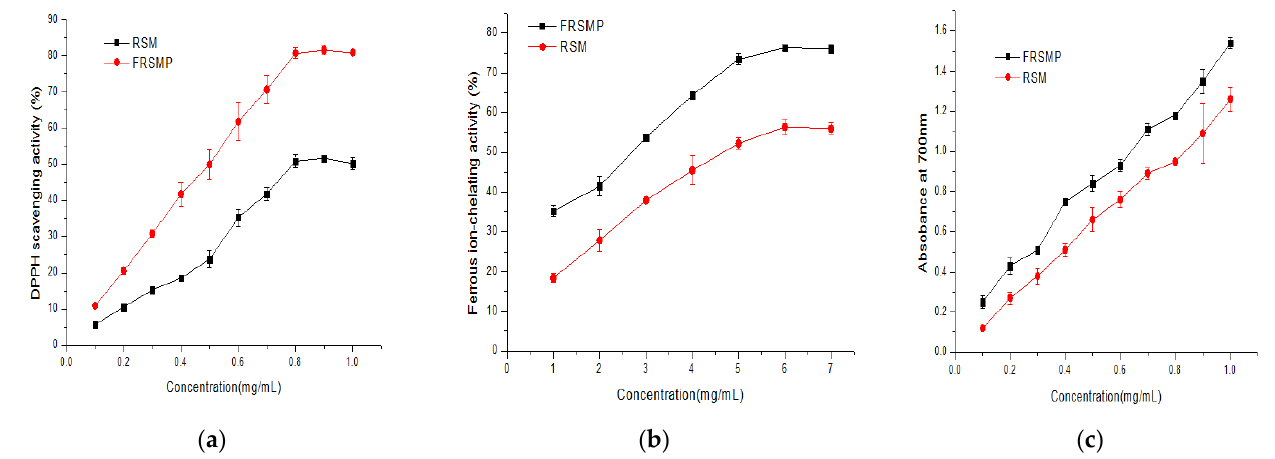
DPPH scavenging activity.